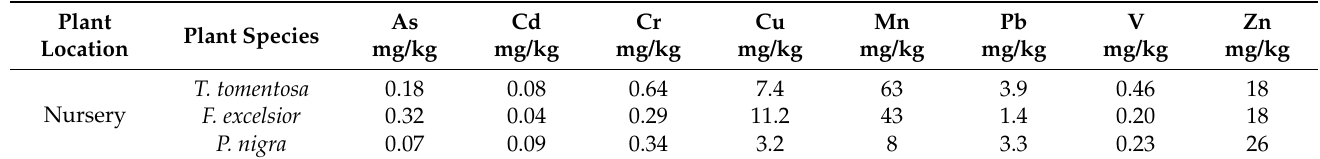
Table 2. Concentrations of some potentially toxic elements (PTEs) in tree leaves/needles (in mg/kg) before transplantation into the urban environment (Plovdiv City, Bulgaria).